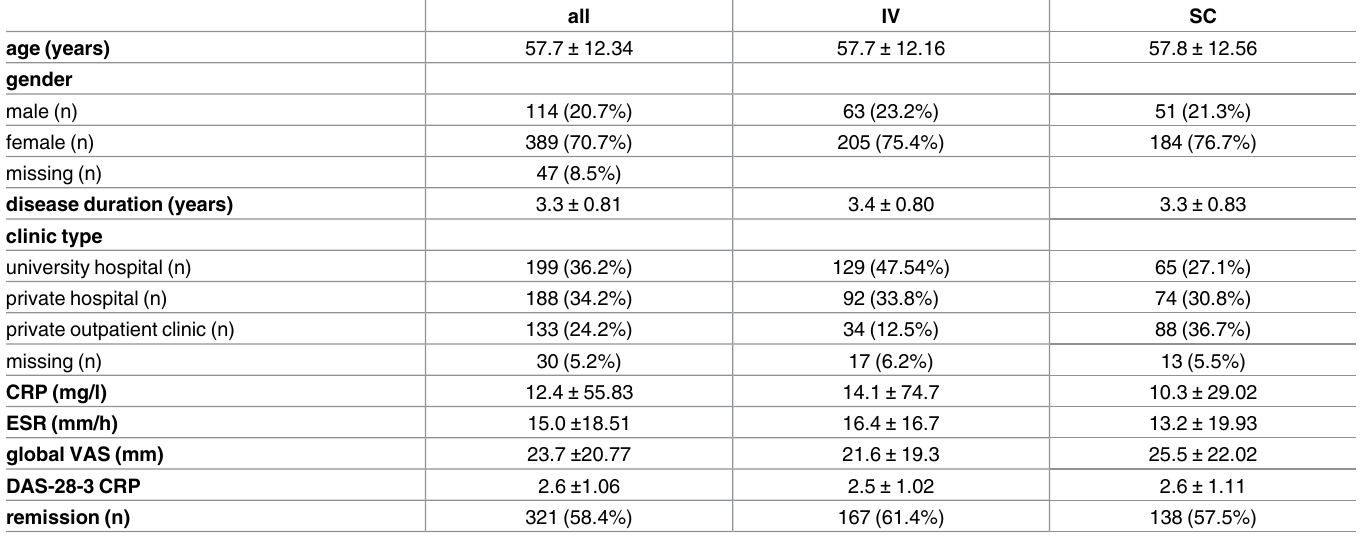
Table 2. Demographic and baseline